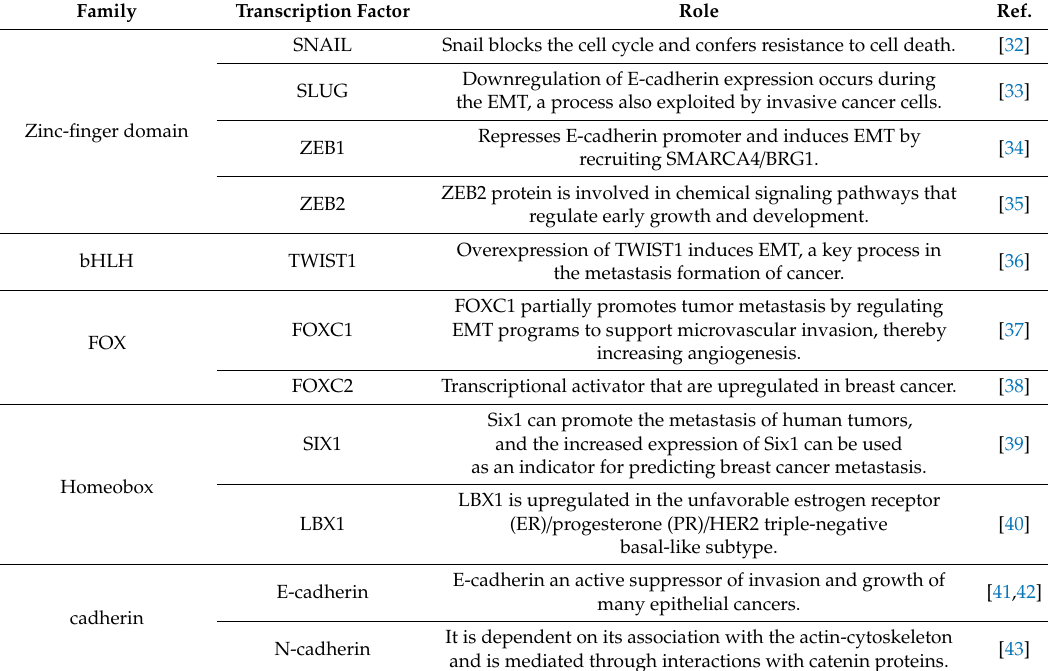
Table 1. List of epithelial-to-mesenchymal transition regulators in cancer